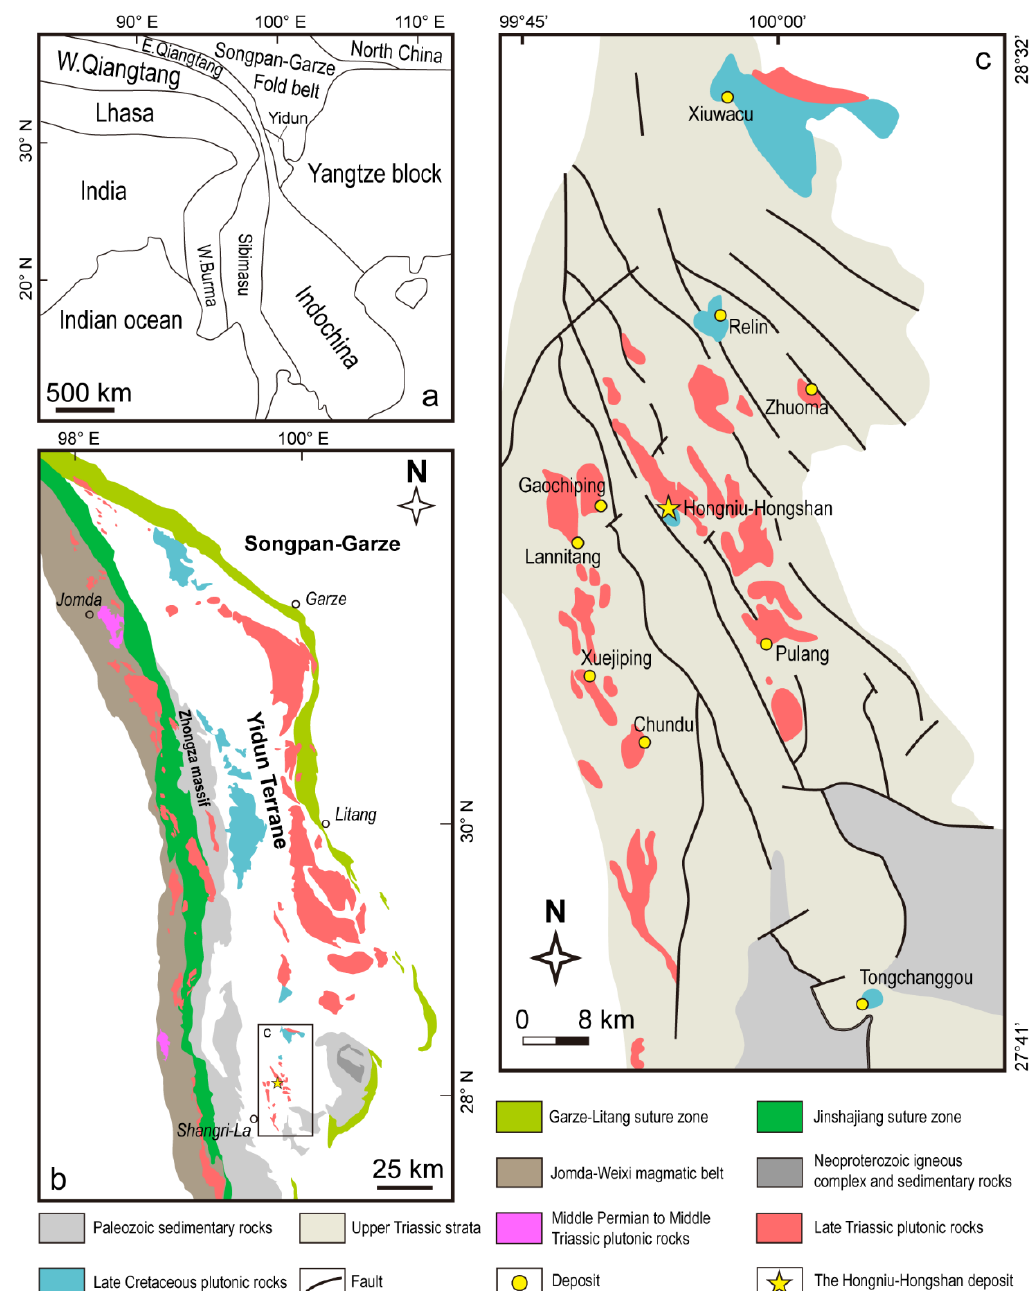
Figure 1. ( a ) Tectonic position of Yidun terrane, modified from Li et al. [34]; ( b ) Distribution of Yidun terrane structure and igneous rocks, modified from Zhan et al. [32]; ( c ) Geological map of Zhongdian district showing the location of plutonic rocks and major porphyry ore deposits, modified from Peng et al. [14].